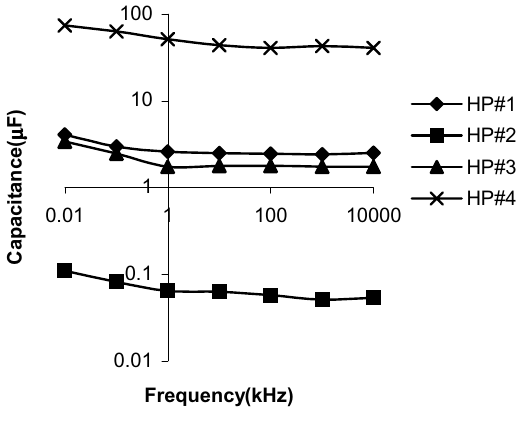
Figure 6. The variation of capacitance against frequency for the In at high vacuum